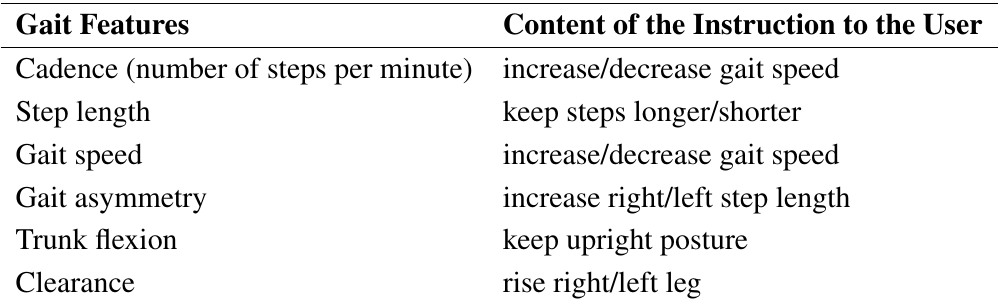
Table 1. Gait features and the corresponding instruction to be fed back to the user in real time and in a closed loop by the wearable sensors and